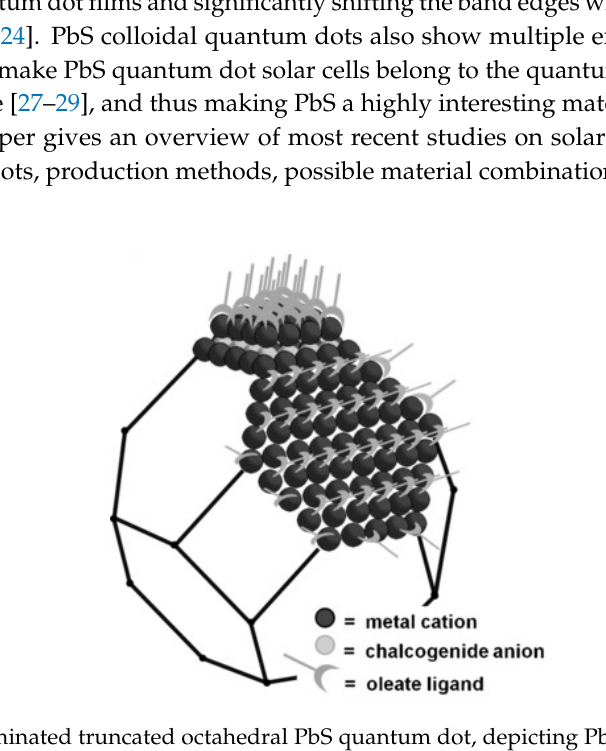
Figure 1. Pb-terminated truncated octahedral PbS quantum dot, depicting Pb cations, S anions and organic ligands. From [12], reprinted with permission. Copyright © Wiley 2016. organic ligands. From [12], reprinted with permission. Copyright © Wiley